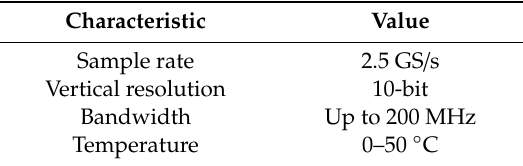
Table 3. Specifications of the acquisition unit.